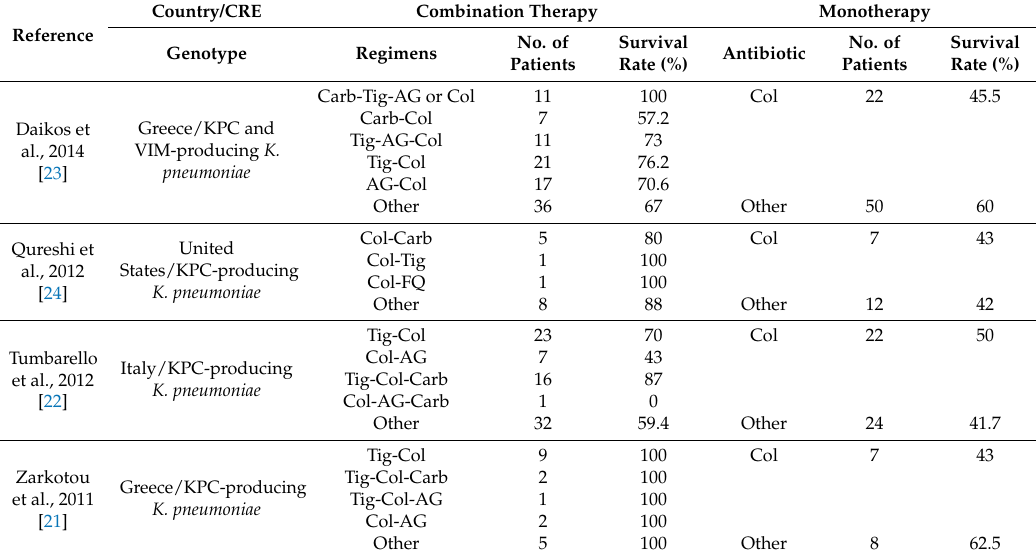
Table 1. Observational studies with data on polymyxin combination therapy and monotherapy for bloodstream infections caused by carbapenem-resistant Enterobacteriaceae